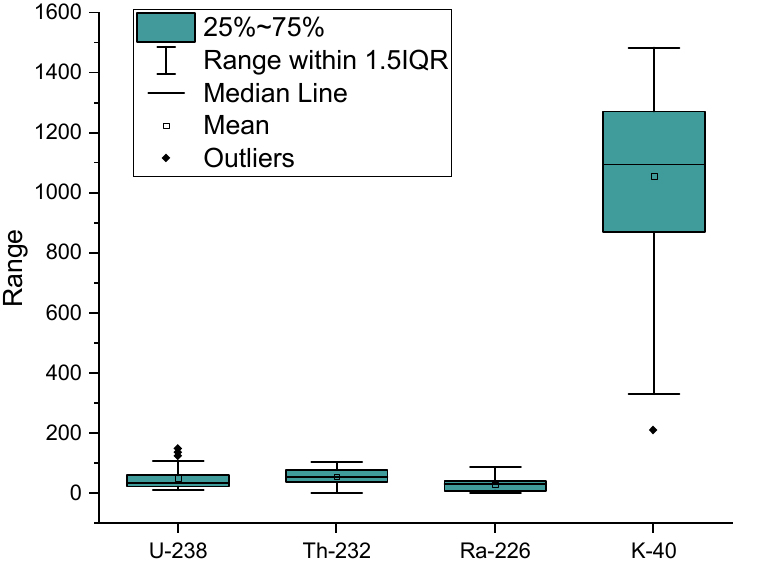
Figure 8. Range, mean, median line and outliers for 238 U, 226 Ra, 232 Th, and 40 K activities in the meas- ured samples in interested area. Table 2. Comparison of activity concentrations of the natural radionuclides ( 226 Ra, 232 Th and 40 K) (Bq kg − 1 ) in granite sam- ples of the present study with those obtained in other published data. Country